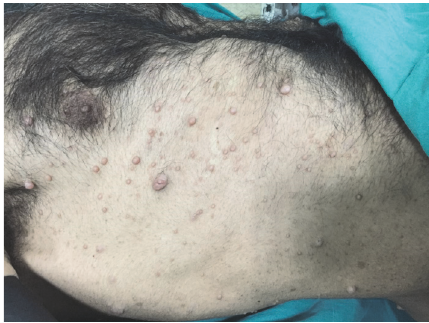
Table 1: Neurofibromatosis Type 1 diagnostic